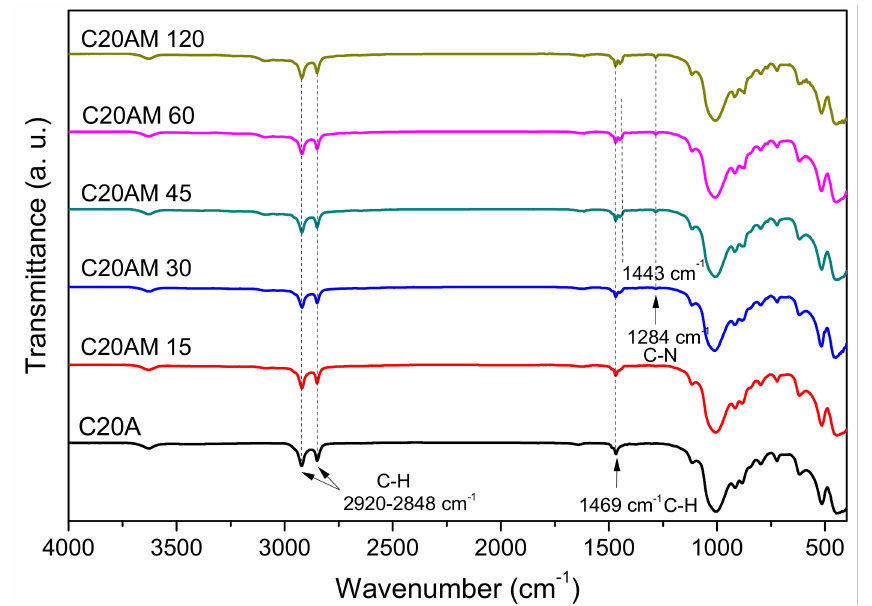
Figure 3. FT–IR spectra of the unmodified nanoclay C20A and the modified nanoclay C20A with 1,4–diaminobutane